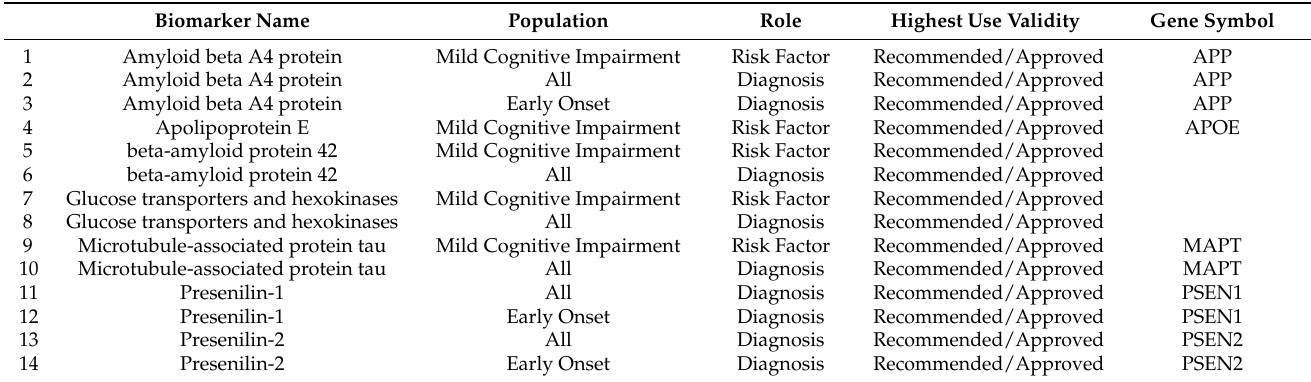
Table 2. Highest validity Alzheimer’s disease biomarkers listed according to their biomarker uses in Alzheimer’s